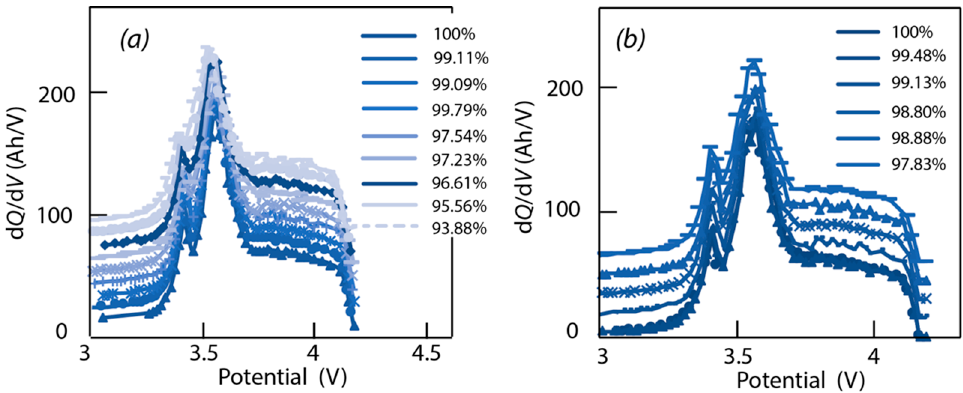
Figure 4. IC curves obtained for ( a ) 23 ◦ , SOC 50, 1C/1D and ( b ) 23 ◦ , SOC 30, 1C/1D. A vertical offset was added for the sake of clarity: the curves have a 10Ah/V-offset and 15 Ah/V-offset.